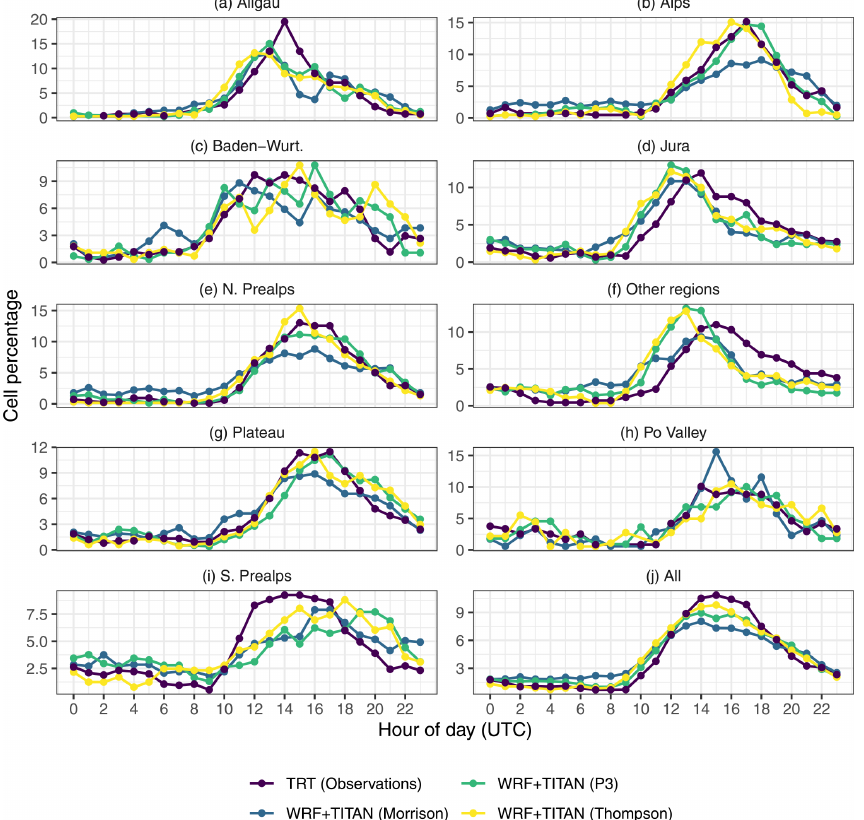
Figure 7. Percentages of cells that were active in each hour of the day per region in May 2018, with observations compared to simulation outputs. Values are the percentage of all unique cell–hour combinations that occurred in each individual hour of the day so that values for each curve sum to 100.